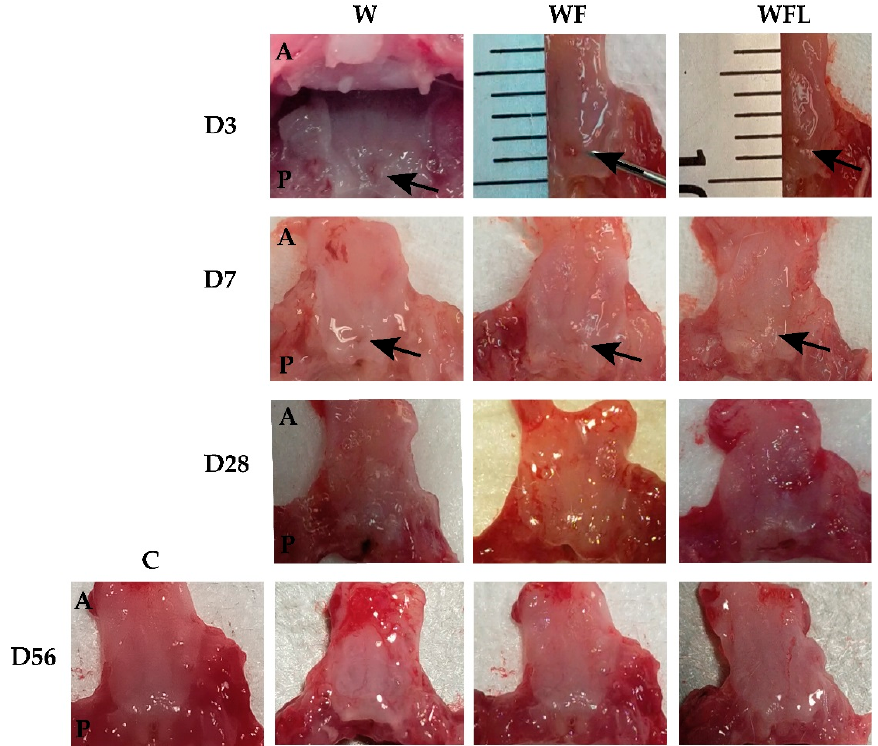
Figure 3. Representative images of the rat soft palate. Tissue samples from day 3 (D3), day 7 (D7), day 28 (D28), and day 56 (D56). A: anterior region of the soft palate. P: posterior side. Wound without implantation (W). Wounded soft palate with fibrin-only implantation (WF). Fibrin with laminin-entactin implantation (WFL). Age control (C) at day 56. D3-W shows the soft palate in the oral cavity during dissection. D3-WF and D3-WFL show the injury located approximately at 1mm from the border of the soft palate. The arrows indicate the wound site in each sample. At days 7, 28 and 56 all the wounds already seem to be epithelialized.